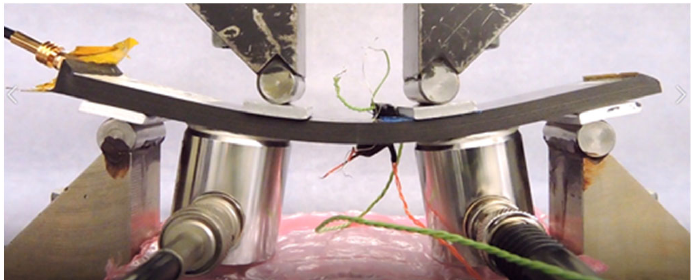
Figure 4. Specimen L3 with large embedded sensor in the four ‐ point bending set ‐ up close to failure.